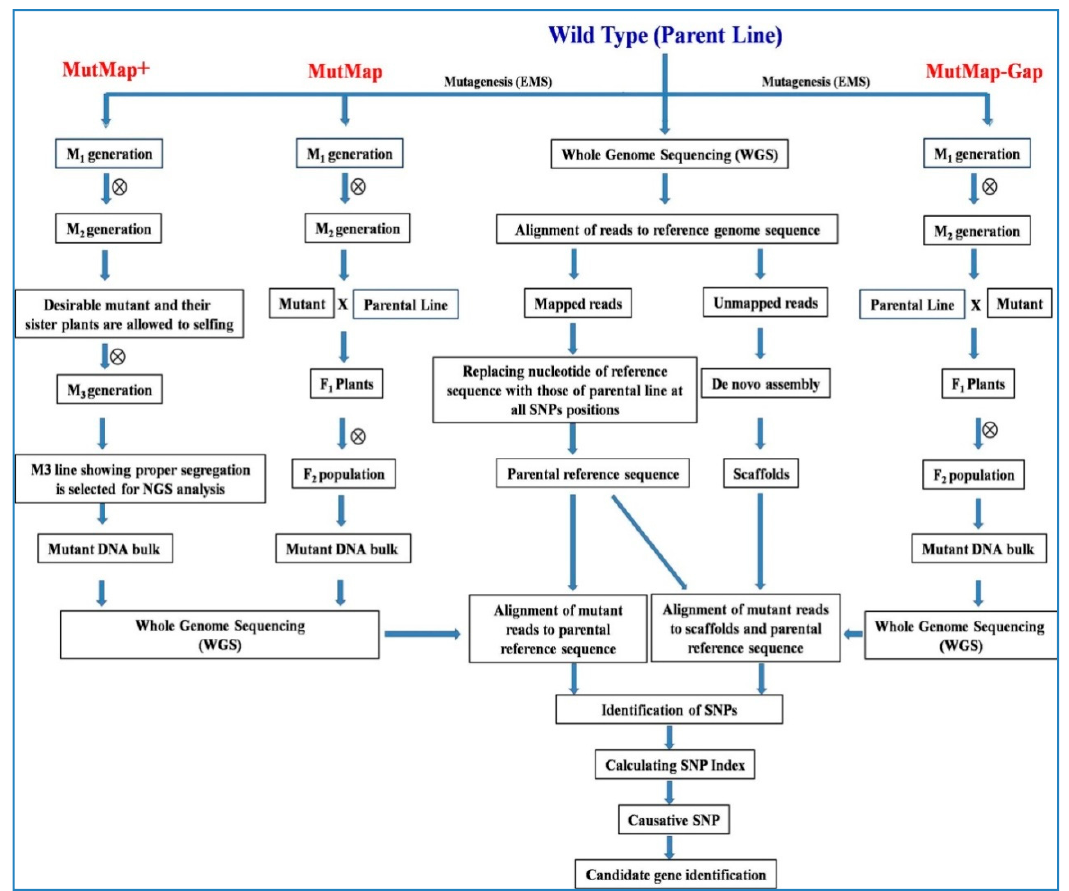
Figure 4. Flow diagram showing the major steps of MutMap, MutMap+c, and MutMap-Gap approaches of forward genetic screen.